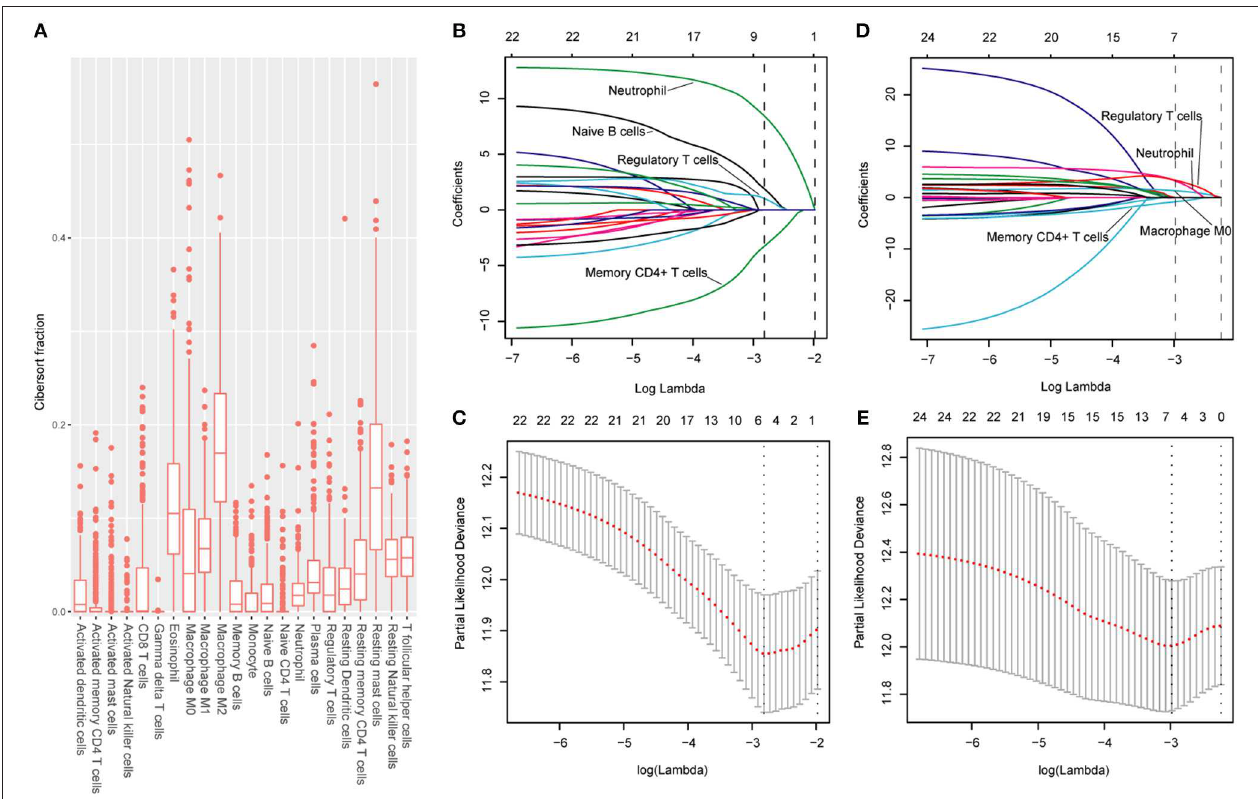
FIGURE 1 | (A) Fraction data of the 22 types of immune cells. (B) LASSO coefficient profiles of the four selected stromal features for disease-free survival. A dashed vertical line is drawn at the value (log γ = − 2.85) chosen by 10-fold cross-validation. (C) Partial likelihood deviance of the LASSO coefficient profiles for disease-free survival. (D) LASSO coefficient profiles of the four selected stromal features for overall survival. A dashed vertical line is drawn at the value (log γ = − 2.9) chosen by 10-fold cross-validation. (E) Partial likelihood deviance of the LASSO coefficient profiles for overall survival. The formulas based on the CIBERSORT and LASSO COX are as follows: IS OS = 1.251* Macrophage stromal + 2.795*Neutrophils stromal + 3.111*Tregs stromal – 0.683*Memory T cells stromal ; IS DFS = 1.890*B cells stromal +